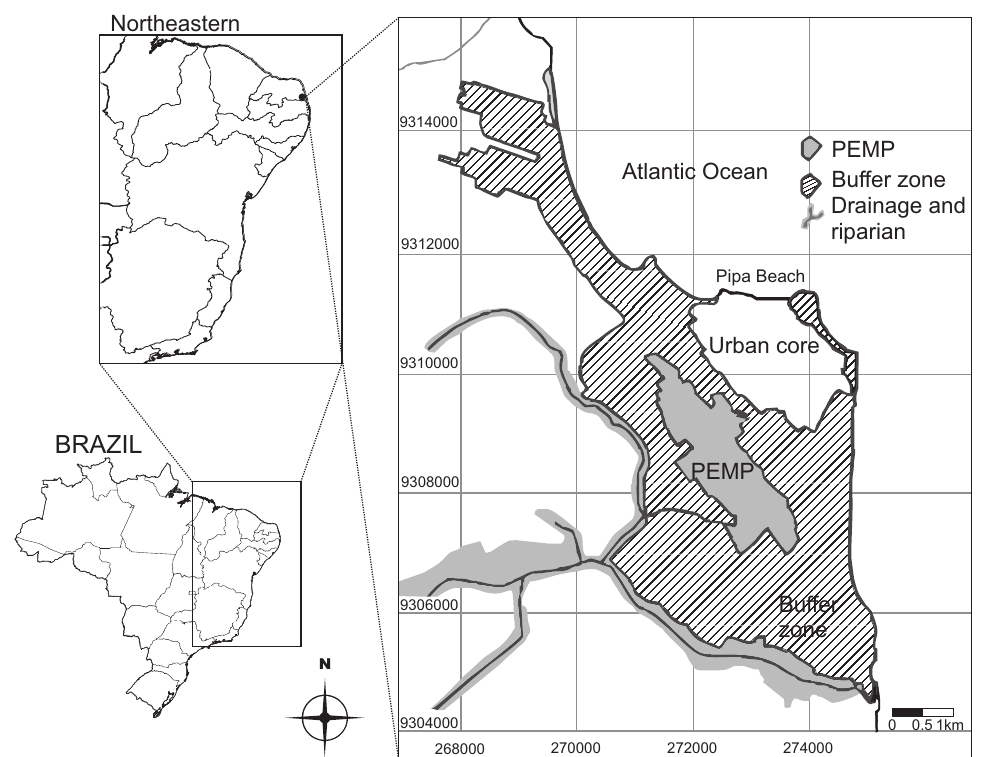
Figure 2. Location of the Parque Estadual Mata da Pipa (PEMP), municipality of Tibau do Sul, state of Rio Grande do Norte, northeastern